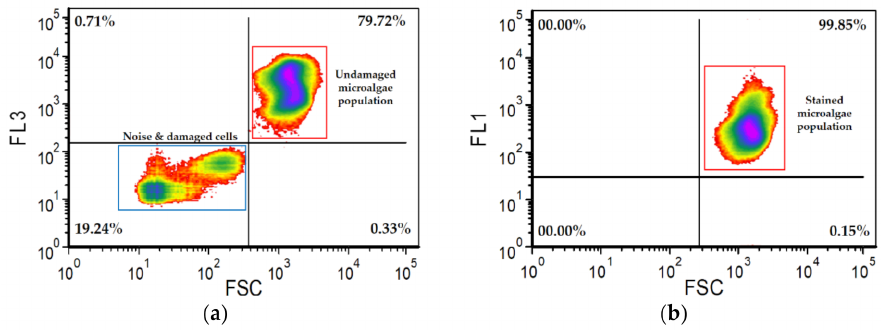
Figure 2. ( a ) FSC vs. FL3 dotplot with rectangular gates for quantification of stained microalgae population. ( b ) FSC vs. FL1 dotplot with rectangular gate for quantification of stained microalgae population only.